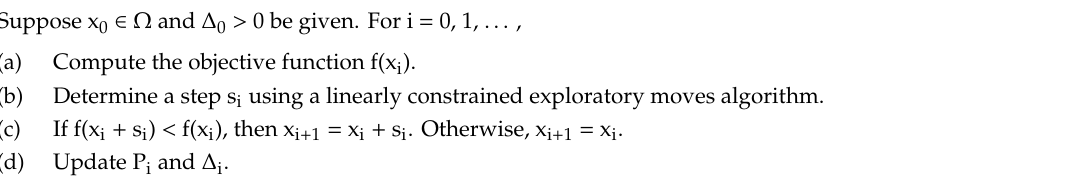
Algorithm 2. The generalized pattern search (GPS) method for linearly constrained